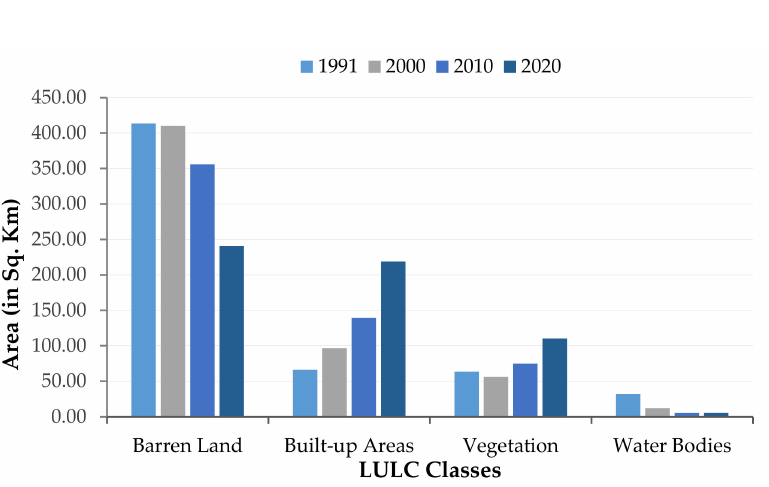
Figure 4. Graphical distribution of land uses for the years 1991, 2000, 2010 and